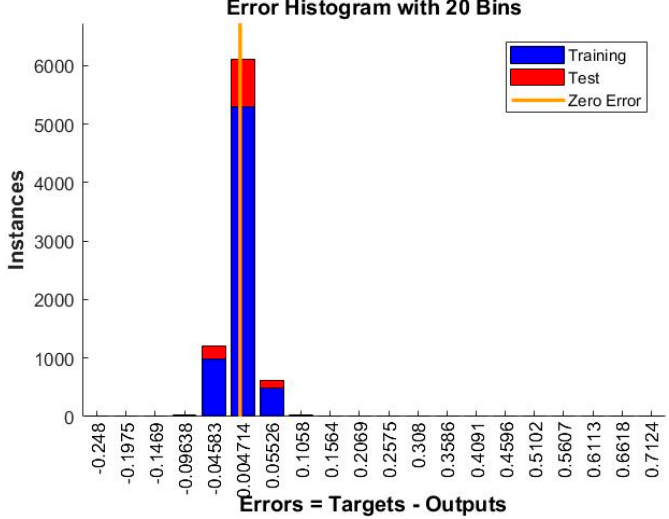
Figure 6. The error histogram when forecasting the electricity consumption for the month of December, using the ANN_NAR_BR network. In this plot, the blue bars represent the training data, while the red bars represent the testing data. Analyzing the plot, we have noticed that in this case, most of the errors fall between − 0.04583